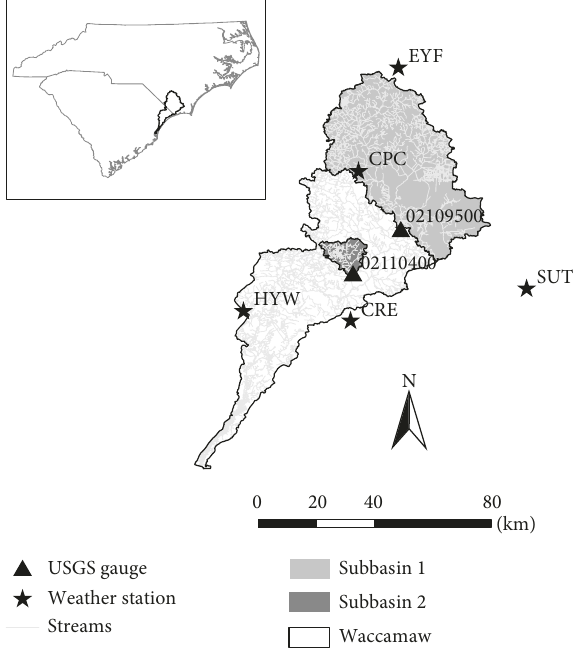
Figure 2: Waccamaw watershed and associated stations for flood